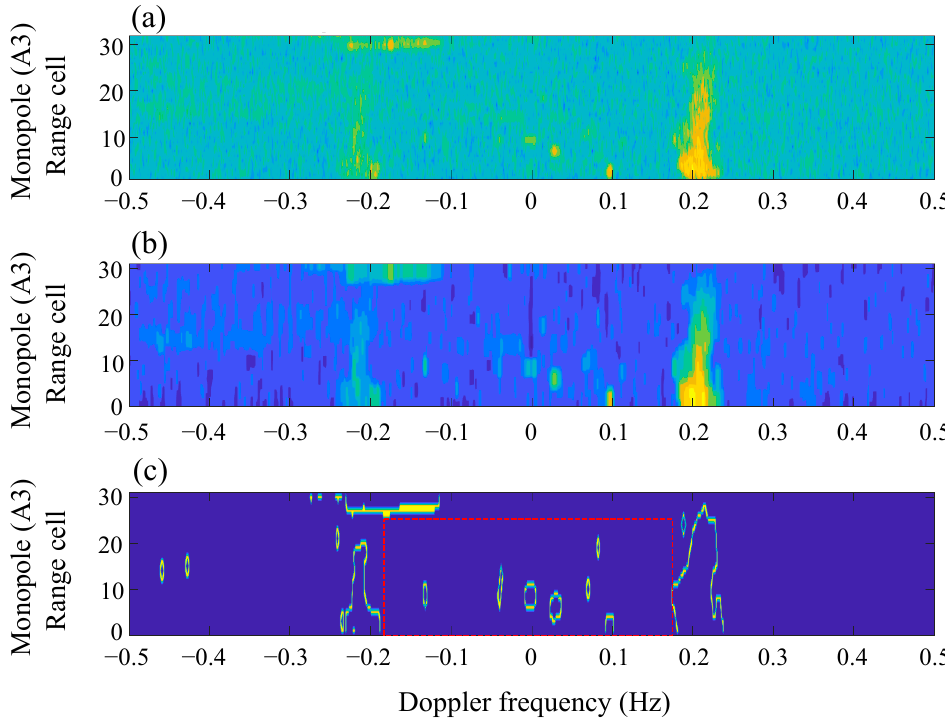
Figure 5. Preprocessing for ROI selection: ( a ) Raw self-spectrum of the monopole of Habn at 07:59:48 on 29 October 2013; ( b ) Result of closing operation on Figure 5a; ( c ) ROI selection from the recognition result of Canny edge detection.